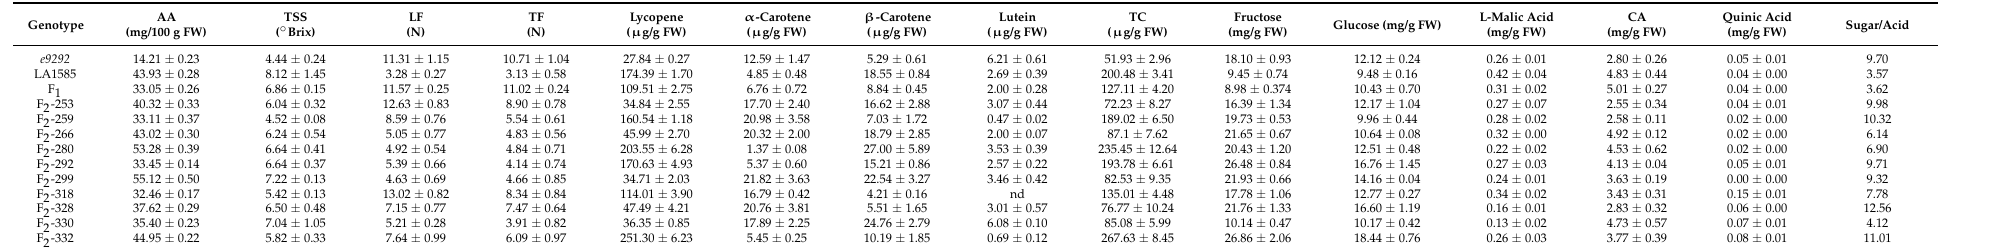
Table 1. Analysis of ripening fruit quality in different